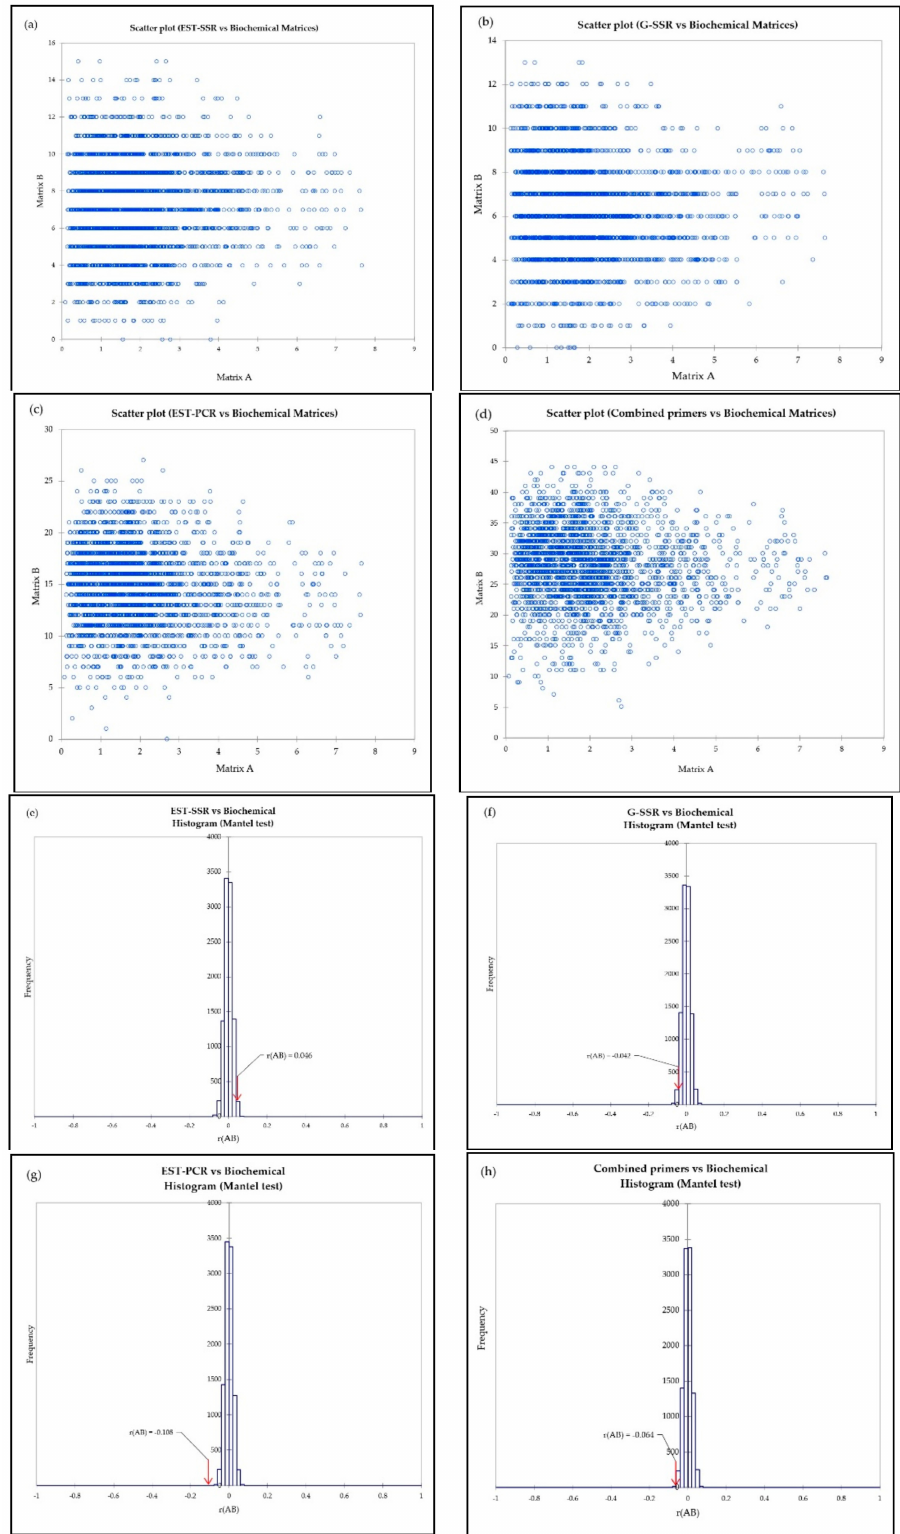
Figure 7. The scatter plot ( a – d ) and histogram ( e – h ) of the Mantel test between biochemical and genetic matrices (EST–SSR, G–SSR, EST–PCR and combined primers,